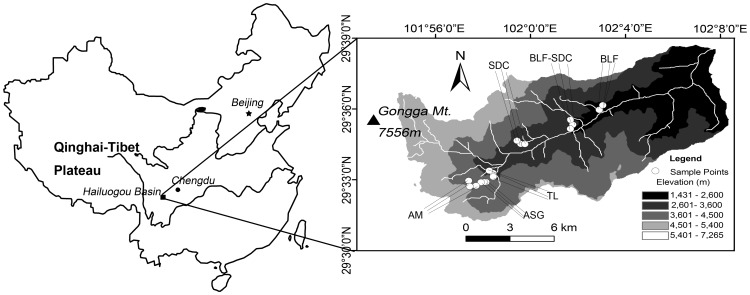
Location of the sampling sites on the eastern slope of Gongga Mountain, SW China.BLF: broad-leaf forest; BLF-SDC: broad-leaf and dark coniferous mixed forest; SDC: subalpine dark coniferous forest; TL: timberline (forest coverage<10%); ASG: alpine shrub-grass; and AM: alpine meadows.